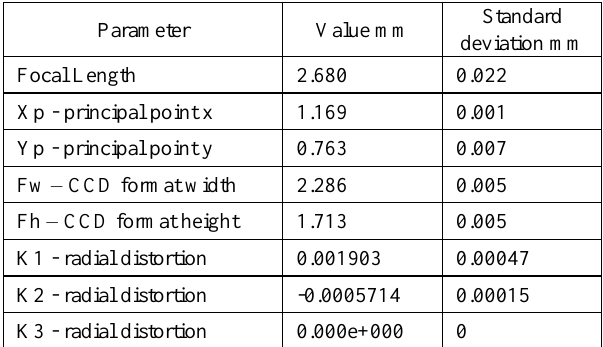
Table 3. Self-calibration results for the iPad 2 camera